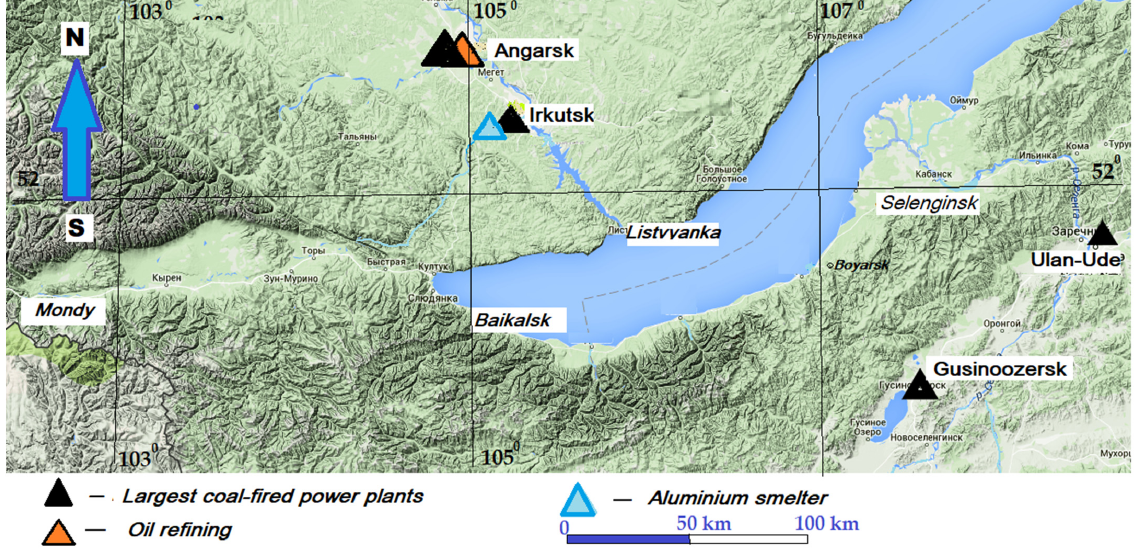
Figure 1. Location of the main industrial centres with systems of state monitoring of the atmosphere in the Baikal